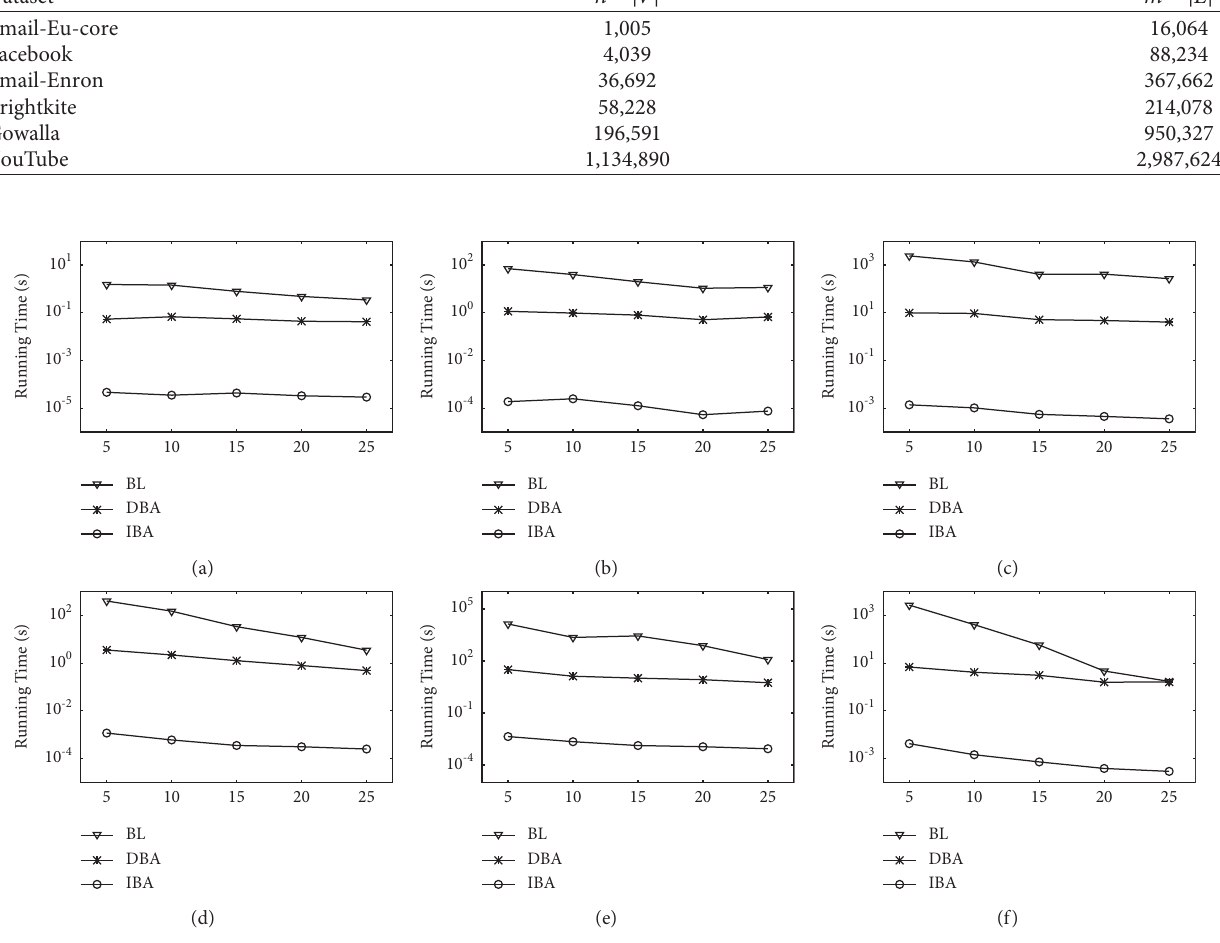
Figure 3: Experiment results by varying parameters k : (a) Email-Eu-core, (b) Facebook, (c) Email-Enron, (d) Brightkite, (e) Gowalla, and (f)